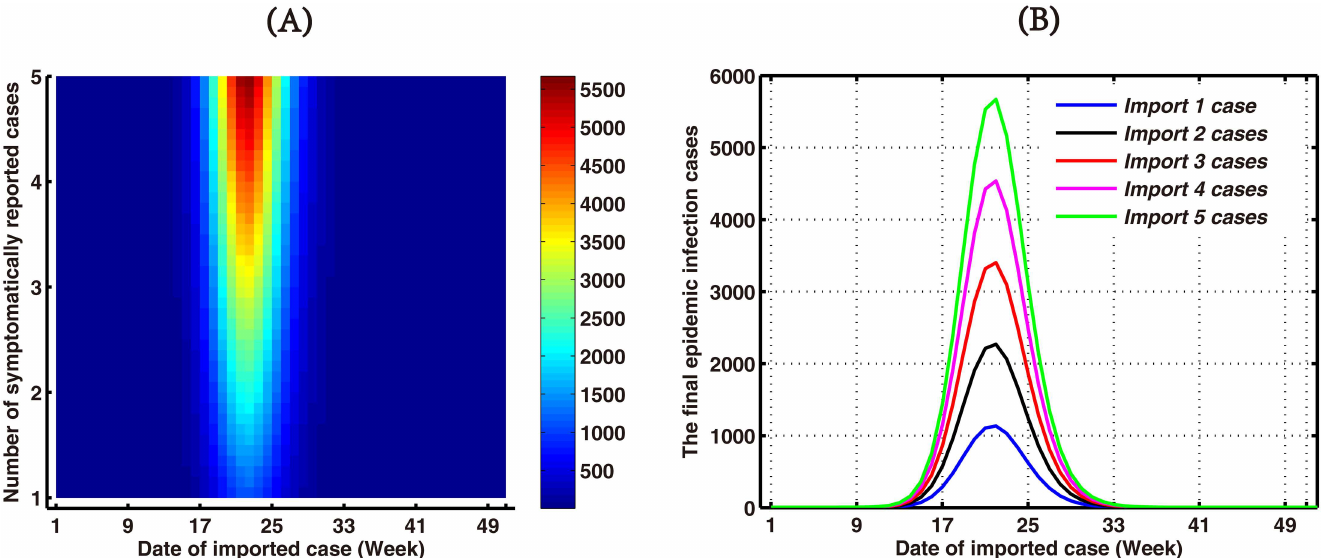
Fig 10. Simulation results for the final outbreak size of 2014 with different importation rates and dates. (A) Hot plot. (B) The final epidemicsize for 2014 after changingthe importation cases and dates. The blue line denotesthe final epidemic size for 2014 after changing the date of 1 importedcase. Black, red, purpleand green lines are 2, 3, 4 and 5 imported cases, respectively.